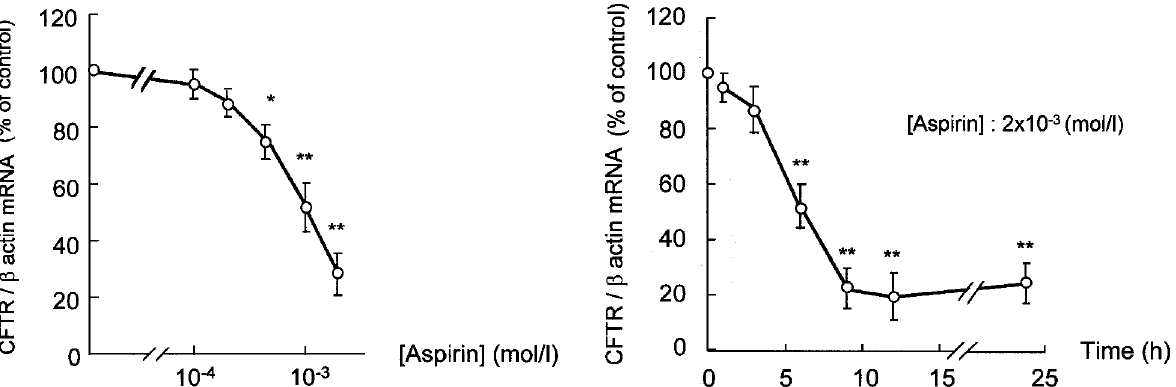
FIG. 4. Northern blot analysis of concentration and time dependence of CFTR mRNA decay induced by aspirin in T-84 cells. The Northern blots were performed using 15 m g total mRNA. The cell content in CFTR mRNA are normalized to the content in b -actin mRNA, and the results are expressed as a percentage of the ratio determined on control cells. (A) Concentration dependence. Cells were treated for 24h with 0, 10 –4 , 5 3 10 –4 , 10 –3 , and 2 3 10 –3 mol/l aspirin. Each value is the mean ±SE of six determinations. * P <0.05; ** P <0.01. (B) Time dependence. Cells were treated with 2 3 10 –3 mol/l aspirin for 0, 1, 3, 6, 9, 12 and 24h. Each value is the mean ±SE of five determinations. ** P <0.01.